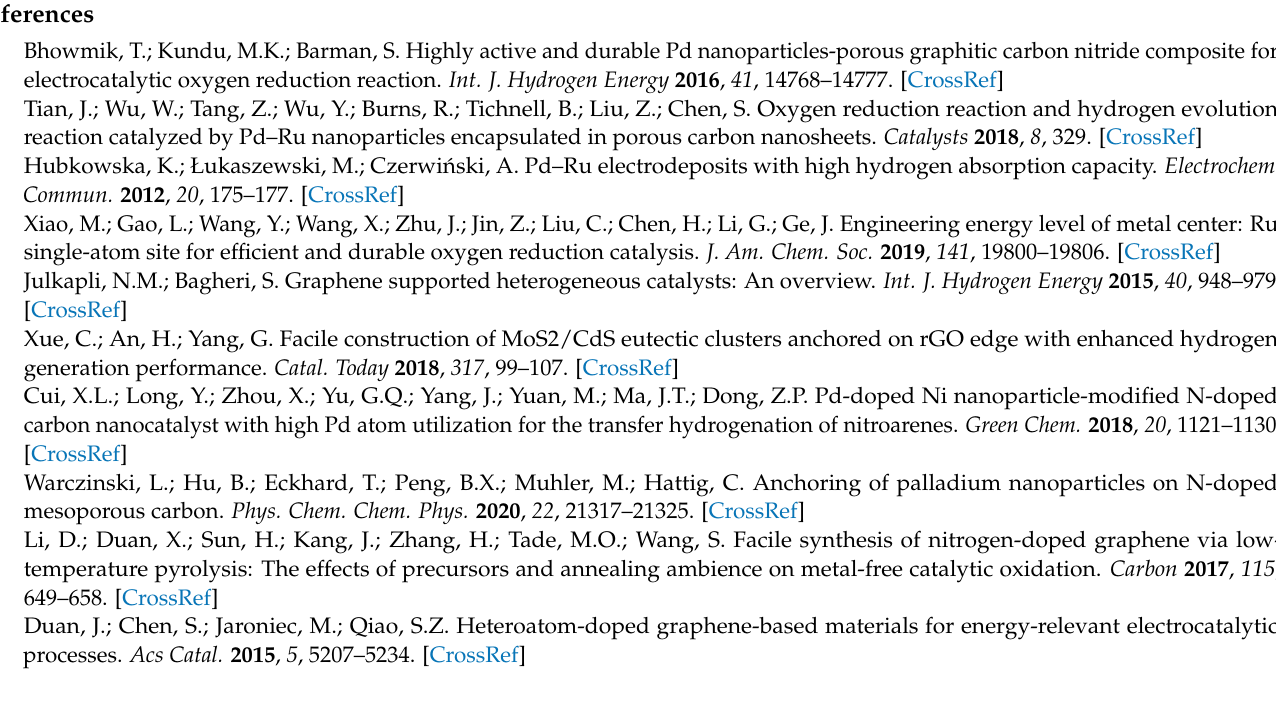
(c) Pd NPs/rGO, and (d) Ru NPs/rGO. Figure S2: SAED patterns of the (a) Pd NPs/NrGO and (b) Ru NPs/NrGO. Figure S3: XPS survey spectra of (a) N 1s of the Pd 4.7 Ru NPs/NrGO and NrGO with dotted line for shifts comparison of pyridinic N, pyrrolic N, and graphitic N, (b) Pd 3d of the Pd NPs/NrGO and Pd NPs/rGO, and (c) Ru 3p of the Ru NPs/NrGO, Ru NPs/rGO. Figure S4: LSV curves of the (a) Pd–Ru NPs/NrGO catalysts, (c) Pd–Ru NPs/rGO catalysts and (b), (d) their corresponding specific activities at 0.3 V RHE . Figure S5: CV curves of the (a) Pd 4.7 Ru NPs/NrGO, (b) Pd 4.5 Ru NPs/rGO and (c) Pt/CB between 1.00 and 1.10 V RHE at different scan rates of 5, 10, 25, 50, 100, 150 and 200 mV/s. (d) Linear fittings of current densities at 1.05 V RHE versus scan rates for the CV tests. Figure S6: TEM images of Pd 4.7 Ru NPs/NrGO after (a) 1000 cycles CV ADT, (b) CA at 0.3 V RHE , (c) CA at 0.75 V RHE and of Pd 4.5 Ru NPs/rGO after (a) 1000 cycles CV ADT, (b) CA at 0.3 V RHE , (c) CA at 0.75 V RHE . Figure S7: The response of (a) Pd 4.7 Ru NPs/NrGO, (b) Pd 4.5 Ru NPs/rGO, and (c) Pt/CB to CO saturation and 1 M CH 3 OH in 0.1 M KOH. Table S1: Elemental contents and of the Pd–Ru NPs/NrGO and Pd–Ru NPs/rGO determined from ICP-OES. Table S2: D-spacing values of the Pd 4.7 Ru NPs/NrGO, Pd NPs/NrGO, and Ru NPs/NrGO calculated from SAED pattens. Table S3: Comparison of the onset potential of Pd 4.7 Ru NPs/NrGO with previously reported Pd and Ru catalysts towards